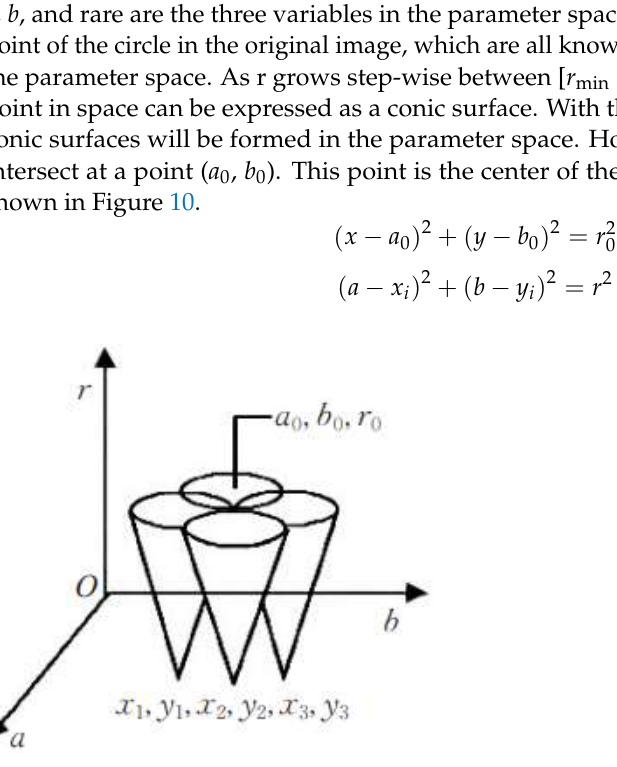
Figure 10. Hough